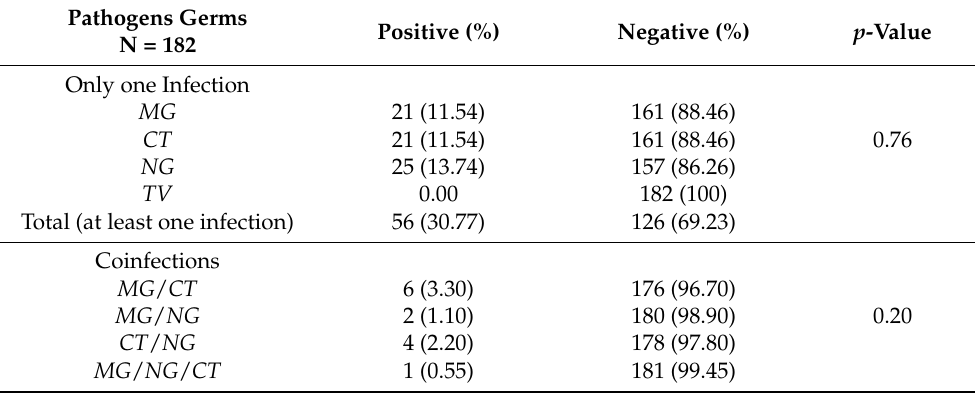
Table 3 indicates the pathogens NG , CT , MG encountered in our study. Table 3. Frequency of pathogens identified by real-time